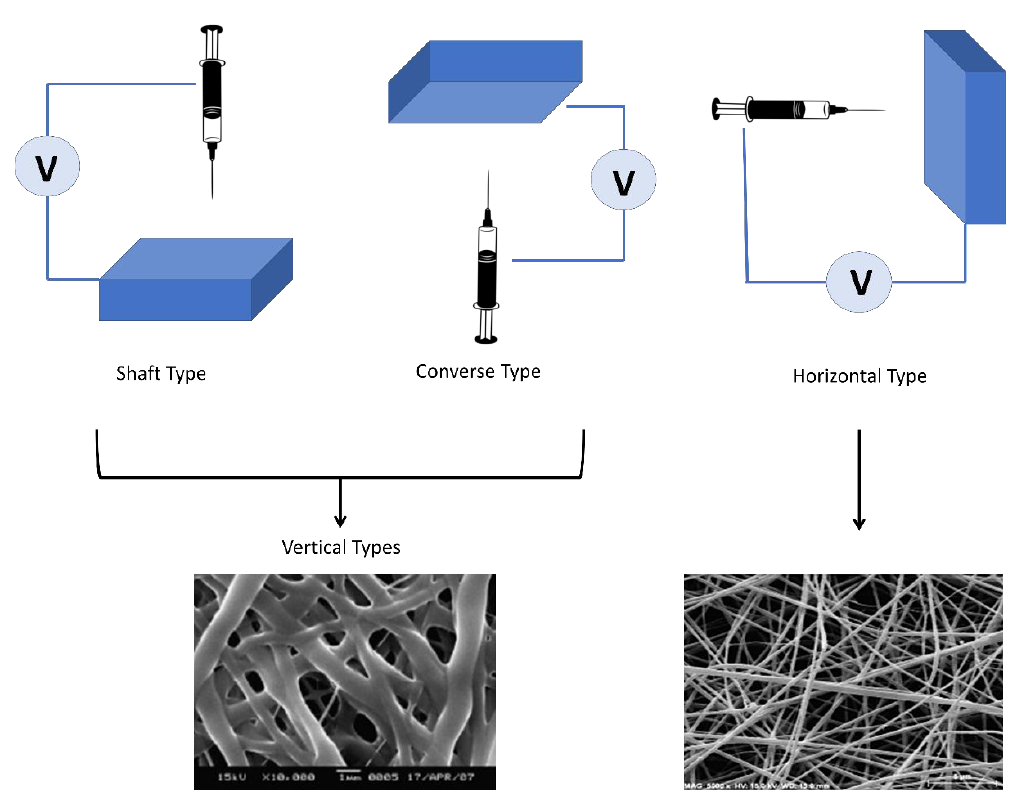
Figure 3. Schematic of electrospinning systems with respective orientation and SEM images of the fibers for the different protein – polysaccharide systems (left: collagen – chitosan composites; right: amaranth protein – pullulan blends) (reproduced with permission from [86,87], Copyright, Elsevier 2010 and 2013).